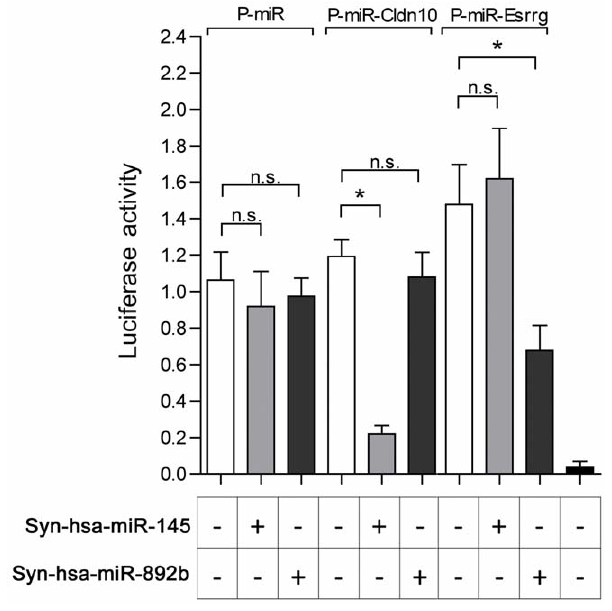
Figure 7. Luciferase Reporter assay performed on FHCE1 immortalized human epididymal cell line. A control plasmid (P- miR), or plasmids containing the 3 9 UTR sequences of Cldn10 (P-miR- Cldn10) or Esrrg (P-miR-Esrrg) were co-transfected in the presence ( + ) or in the absence ( 2 ) of mimics Syn-Hsa-miR-145 or Syn-Hsa-miR-892b. Values of control non transfected cells are indicated in the last column. Data are means 6 SEM from three independent experiments. ns: non significant, *: P-value # 0.05.